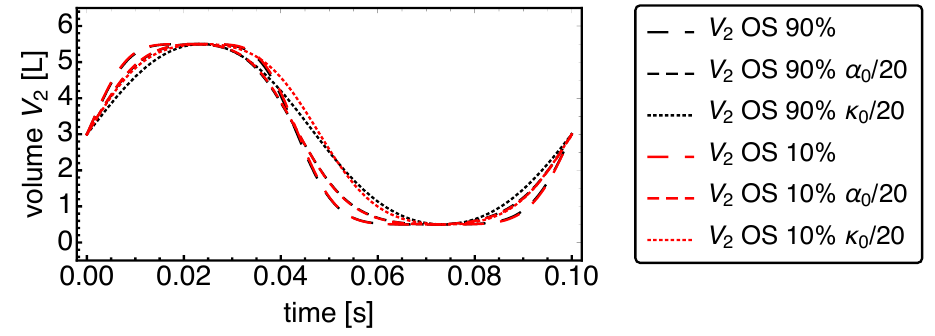
Figure 11. The optimized volume dynamics of the cold cylinder is shown as a function of time for the reference , low mass transfer and the low conductance cases with r = 10% and r = 90%. The influence of the regeneration coefficient is clearly visible, but the impact of the different cases is considerably smaller than for the hot